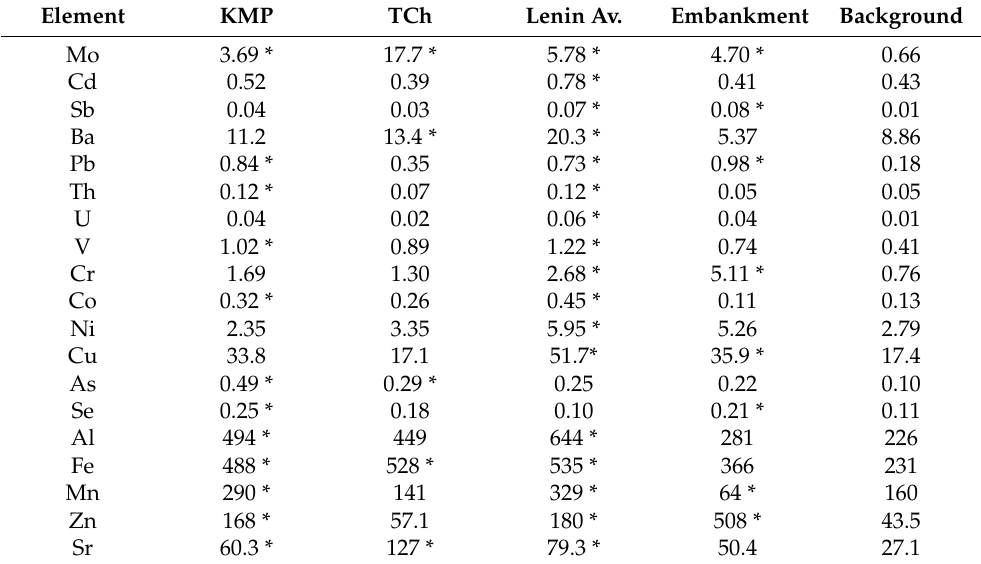
Table 10. Removal of elements from soils Echinochloa frumentacea in the case of polyelement pollution, g/ha. Element KMP TCh Lenin Av. Embankment